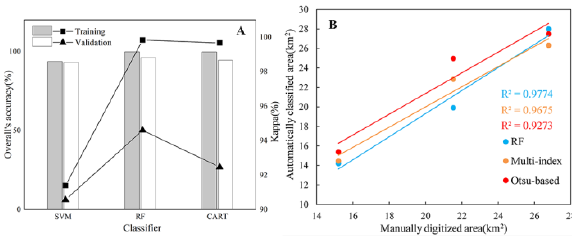
Figure 3. A) Model accuracy of three machine learning algorithms(bar plot is overall’s accuracy and line chart are Kappa coefficient); B) linear fit of estimated values to manually digitized values. Table 1 Comparison of debris cover area values derived from automatic extraction algorithms and manual digitisation Multiple digitisations (km 2 ) Glacier